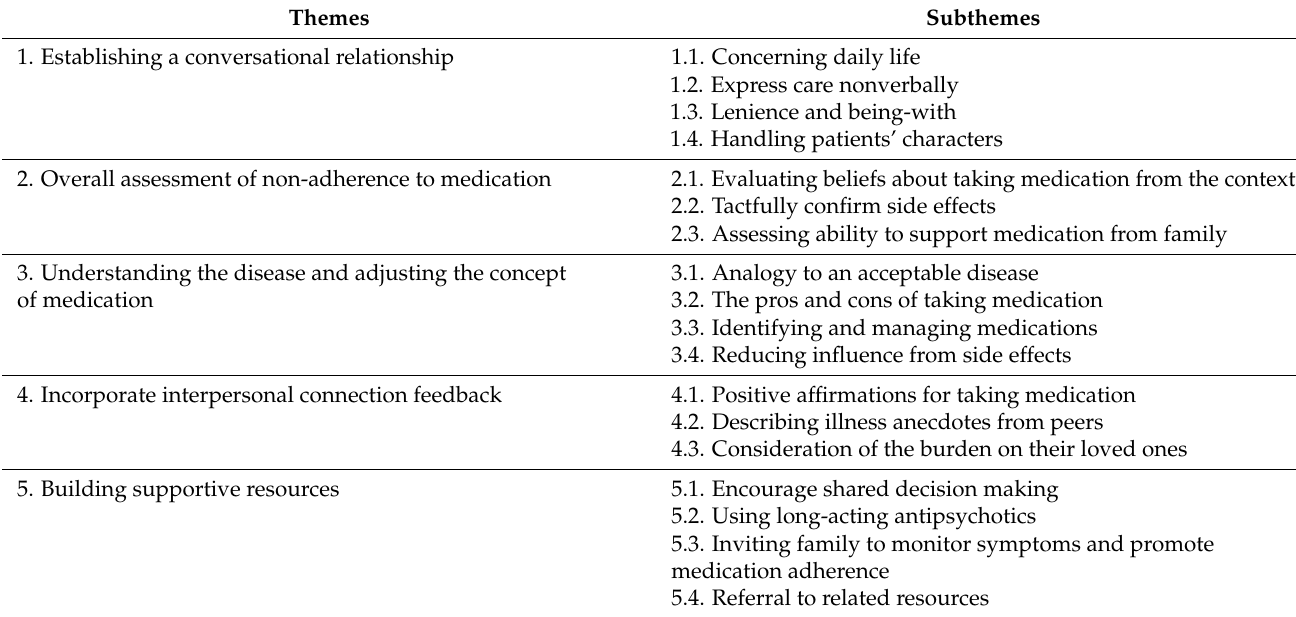
Table 2. Summary strategies of MHNs to promote medication adherence in